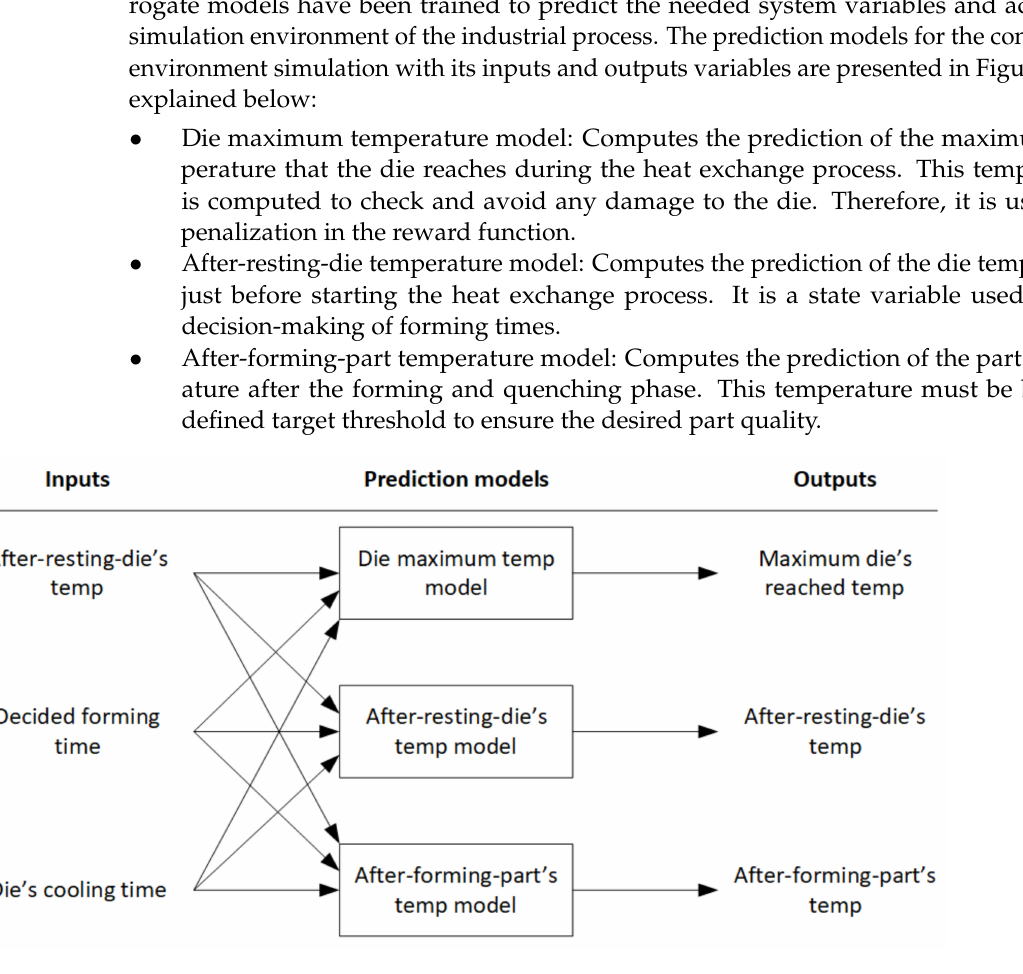
Figure 5. Data-driven prediction models for the continuous environment